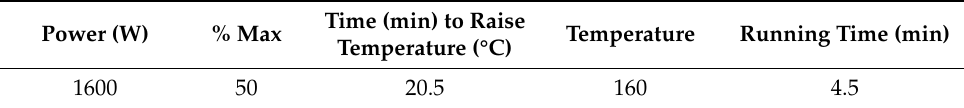
Table 1. Parameters used during microwave